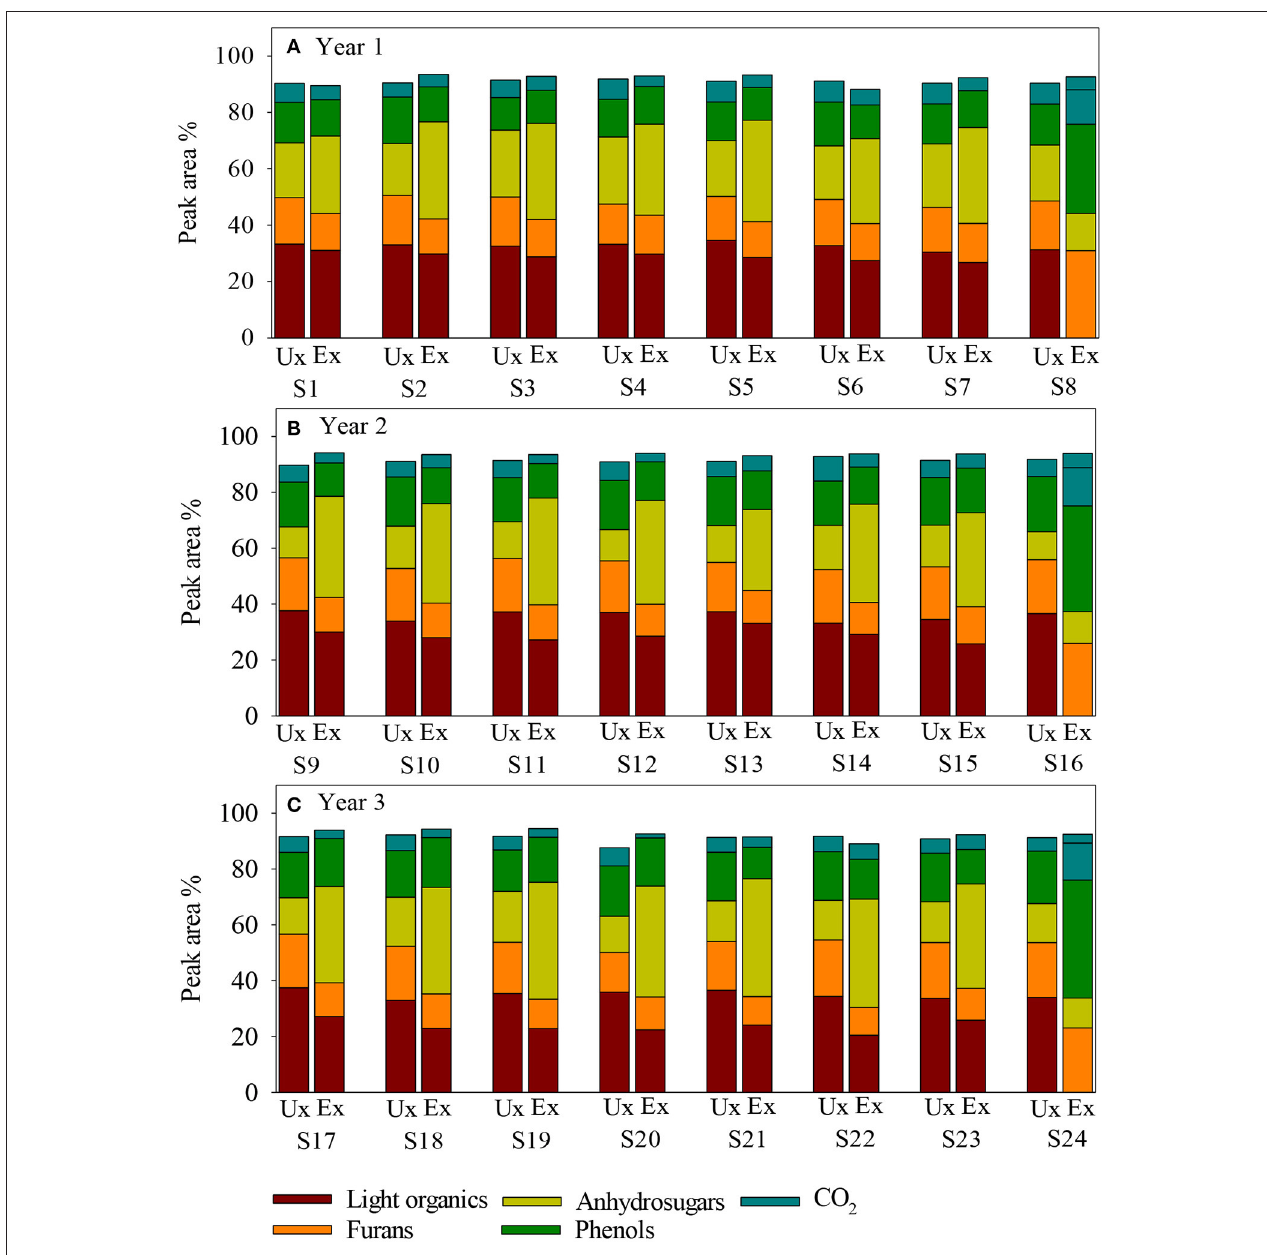
FIGURE 6 | Distribution of chromatographic peak area % of pyrolytic products in the untreated (Ux) and extractives-free (Ex) switchgrass samples harvested for 3 consecutive years. (A) year 1, (B) year 2, (C) year 3.